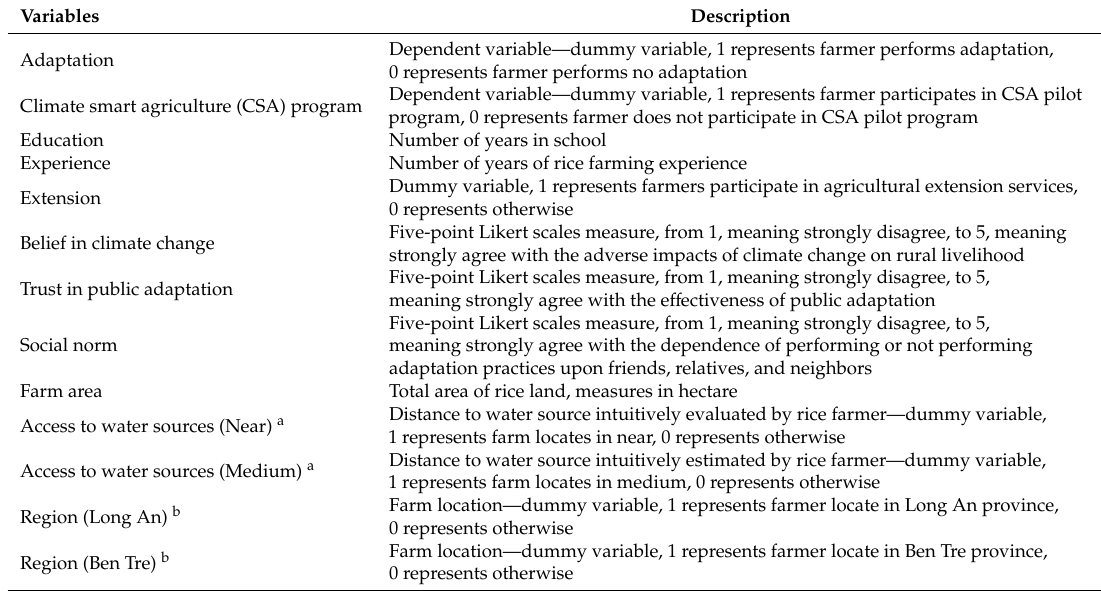
Table 1. Description of explanatory variables in the binary logistic